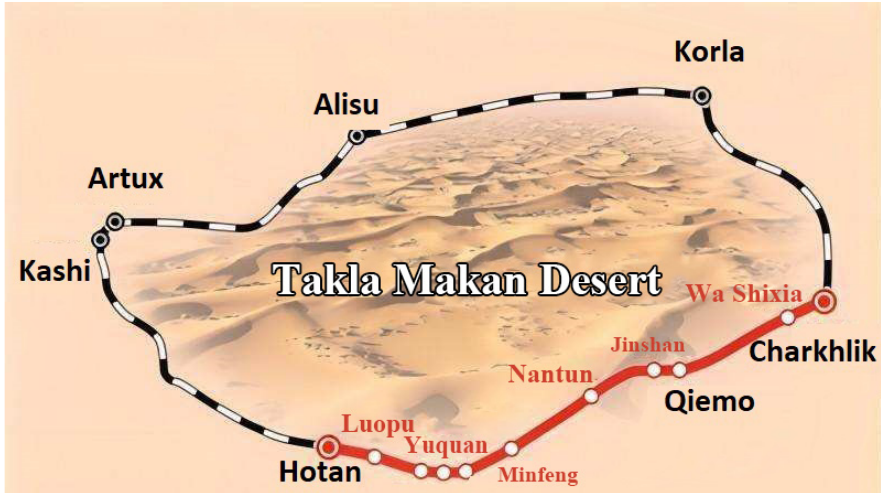
Figure 1. The railway around the Takla Makan